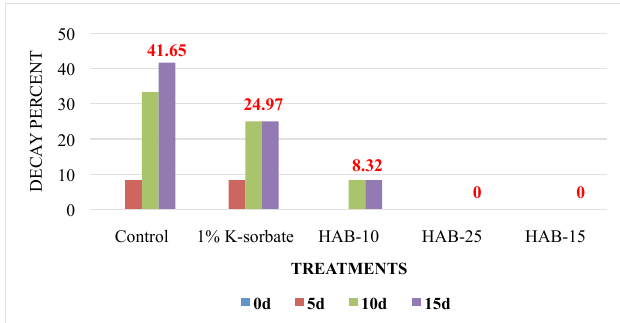
Fig. 2A: Effect of fluorescent Pseudomonas species on decay percent of tomato stored at